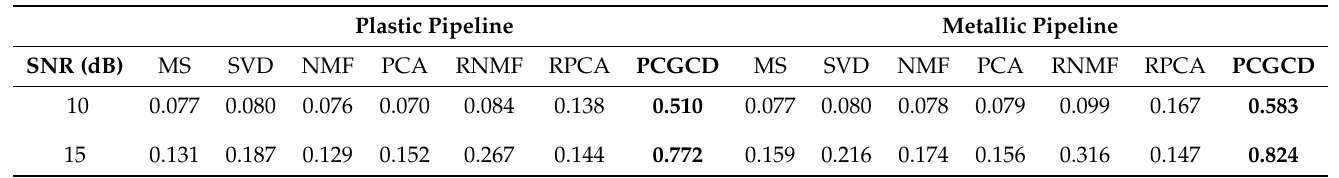
Table 6. The average of ( SSIM ) results with different SNR.